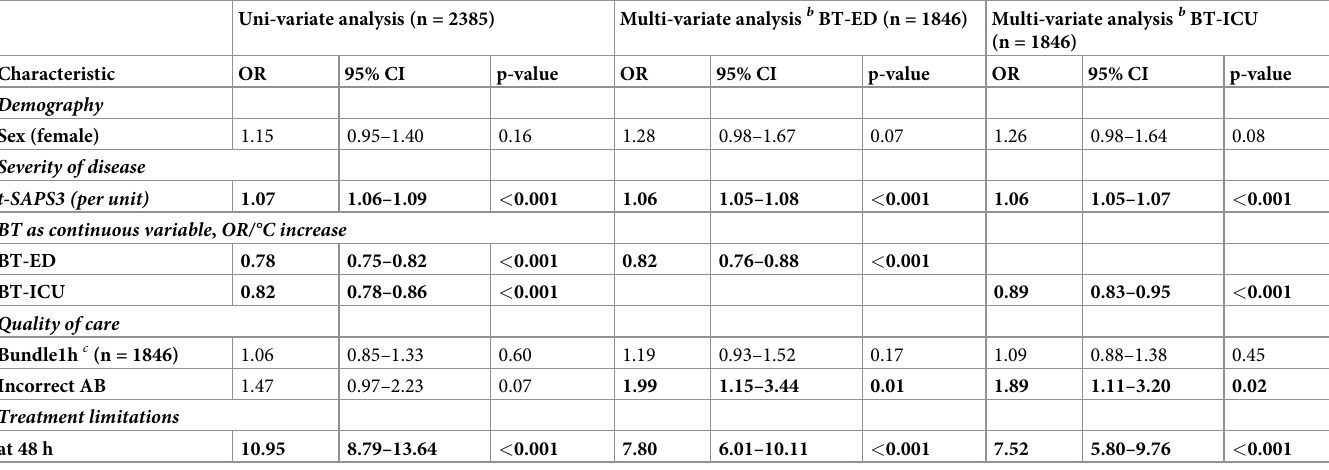
Table 2. Odds ratios for death according to ED and ICU admission temperature a